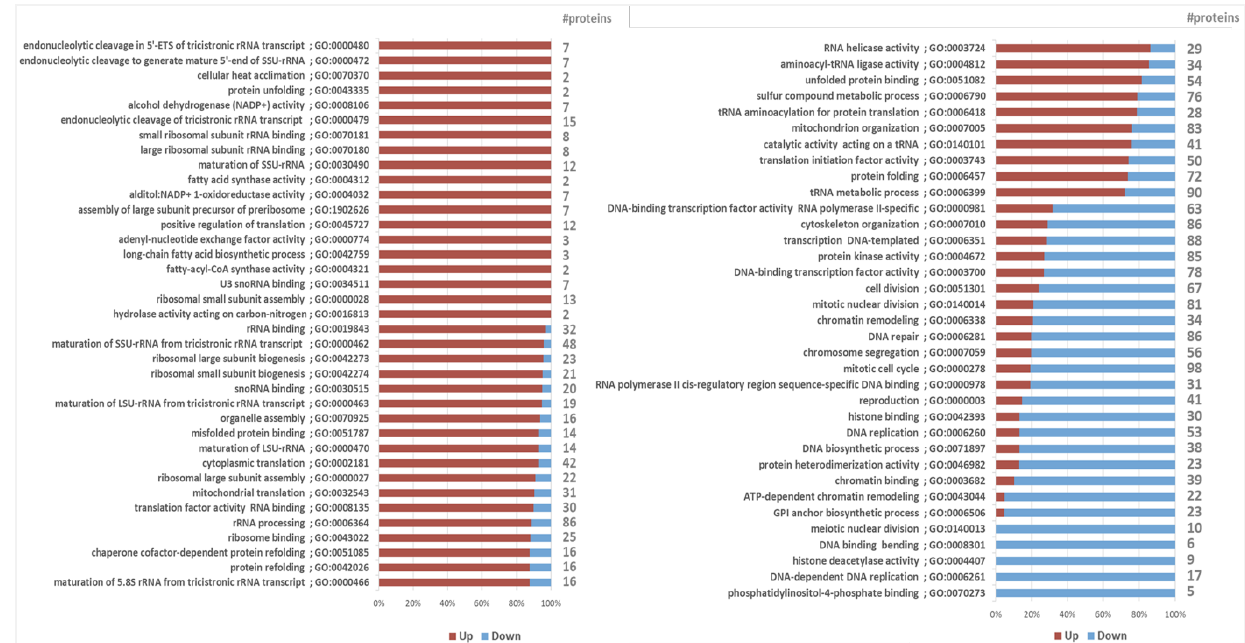
Figure 3. Gene set analysis of protein expression at maximized lipid yield. Protein sets are defined by GO terms. For each GO term showing significant enrichment (in this figure: adjusted p -value < 0.02), the direction of the relative changes in protein levels are shown, together with the total number of proteins within each GO term. Note that GO term annotations are redundant and the same genes are likely members of multiple GO terms.